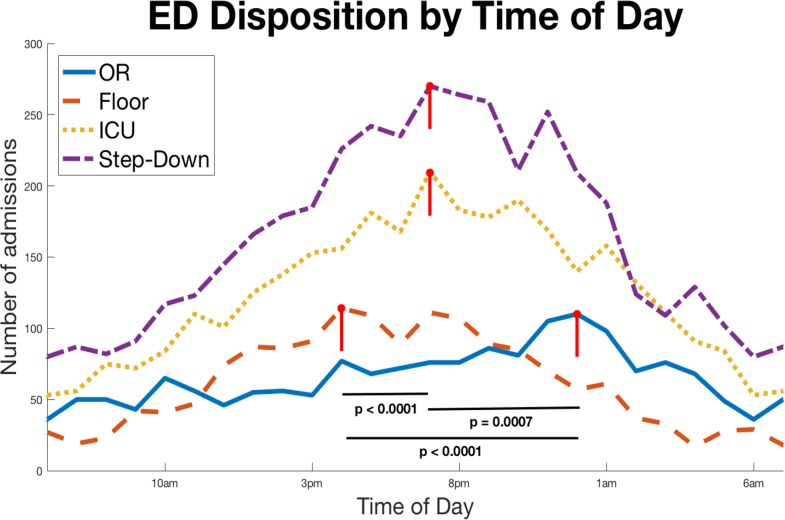
Absolute frequency of trauma patients sent from the emergency department to each of these disposition by time of day.Patients admitted to the floor peak earliest (red-dashed). Step-down (purple-dashed) and ICU (yellow-dashed) peak next during the day, and operative patients present latest.